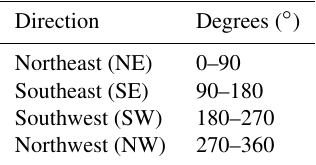
Table 3. Definition of wind directions of incoming air